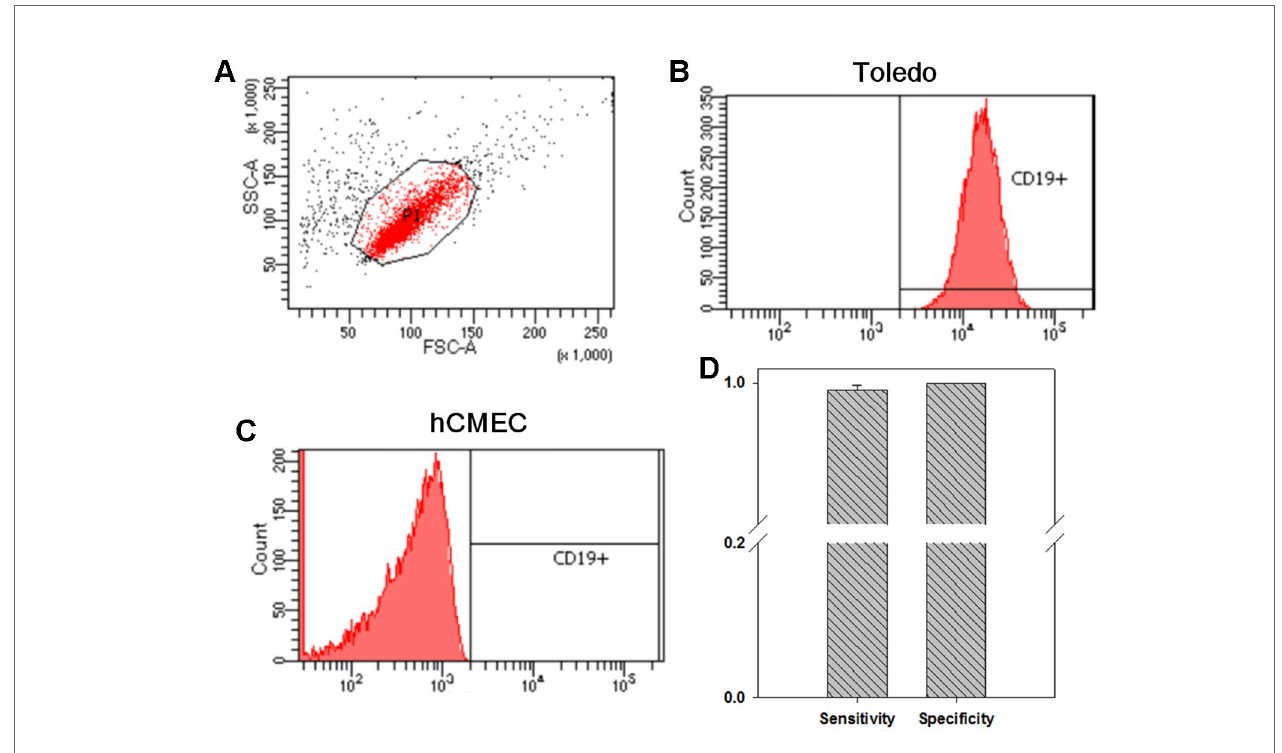
FigUrE 1 | The investigation on whether flow cytometry with CD19 antibody staining distinguishes B cells from blood–brain barrier (BBB) endothelial cells. We investigated the distinguishability of flow cytometry on the two types of cells. (A) We first determined the specified FSC-A and SSC-A values which would be applied to gate the cells without treatment. (B) Among the 10,000 gated Toledo cells (one type of B cell), 9,965 ones were detected to be CD19 + . (c) Among the 10,000 gated hCMEC cells (one type of BBB endothelial cell), no one was detected to be CD19 + . (D) By three independent assays, in average, 9,954 Toledo cells and 0 hCMEC cells were detected to be CD19 + , leading to a 99.54% sensitivity and a 100% specificity in recognizing B cell by CD19 antibody staining (N = 3). Data was presented as mean ±